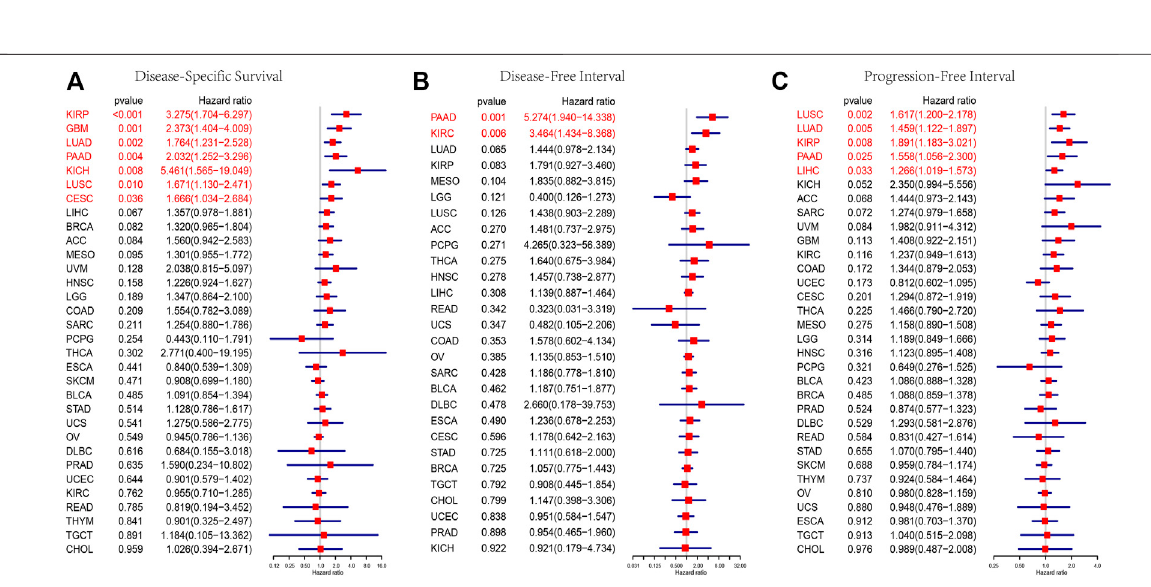
Frontiers in Cell and Developmental Biology |